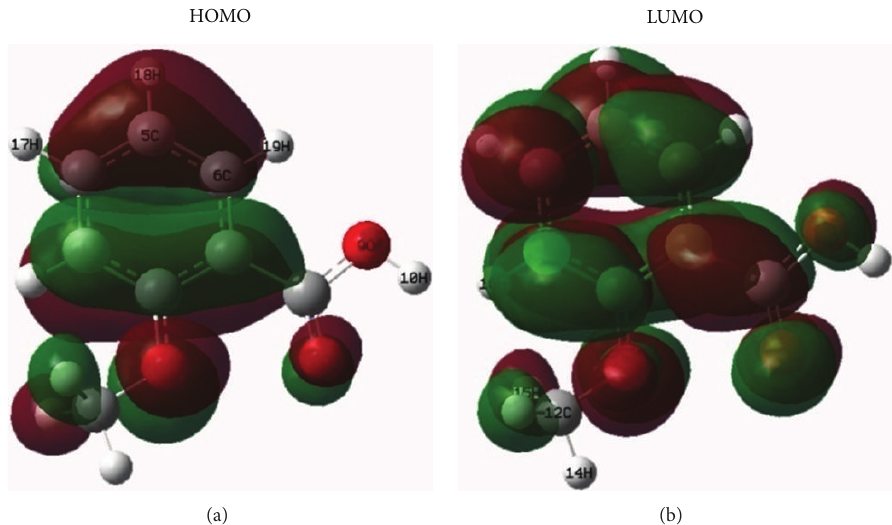
Figure 6: Contour surfaces of frontier molecular orbitals of O-Anisic acid.